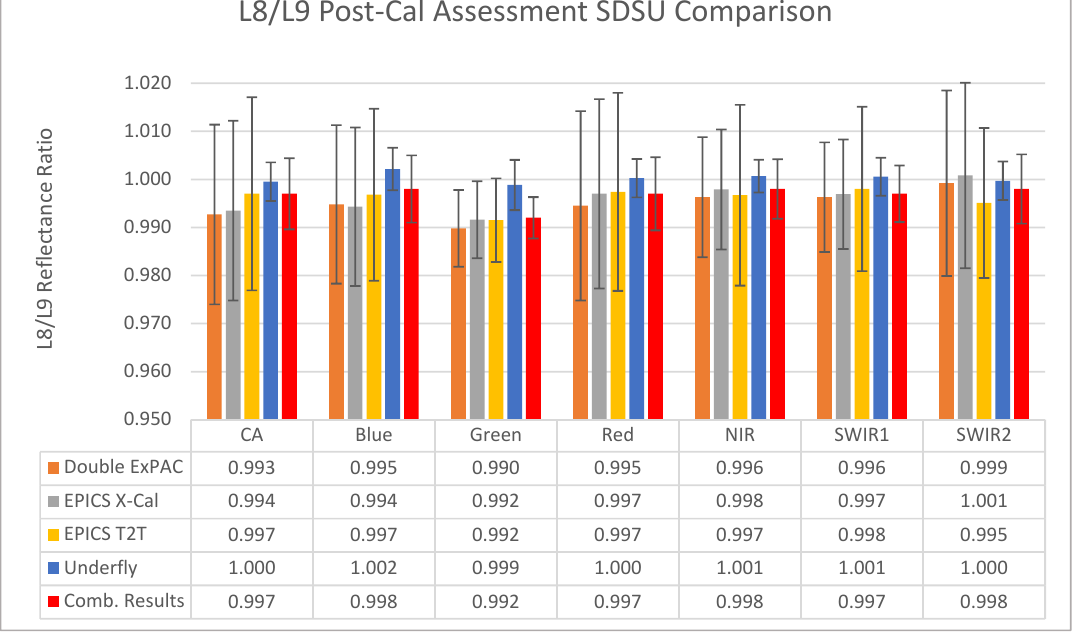
Figure 15. Post-calibration comparison. SDSU validated the initial cross-calibration results with multiple approaches, all showing the sensors agree to within 1%. The blue bars indicate the approach taken in this paper, with the red bars indicating the method that incorporates all of the approaches.